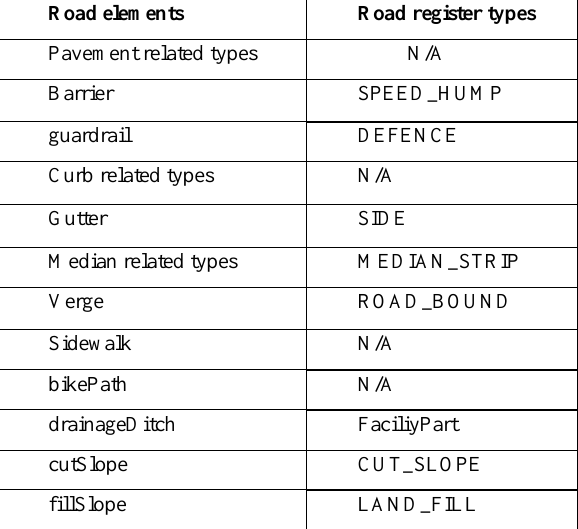
Table 2. Corresponding types between road elements and road register types